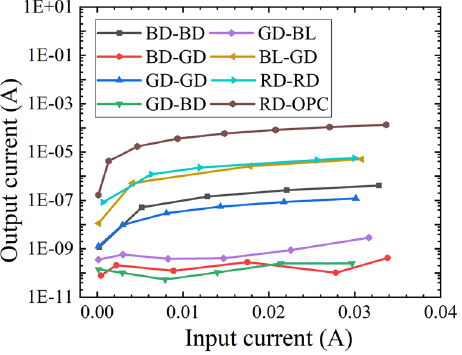
Figure 4. Output current versus input current of optocuplers with various types of emitters and detectors.